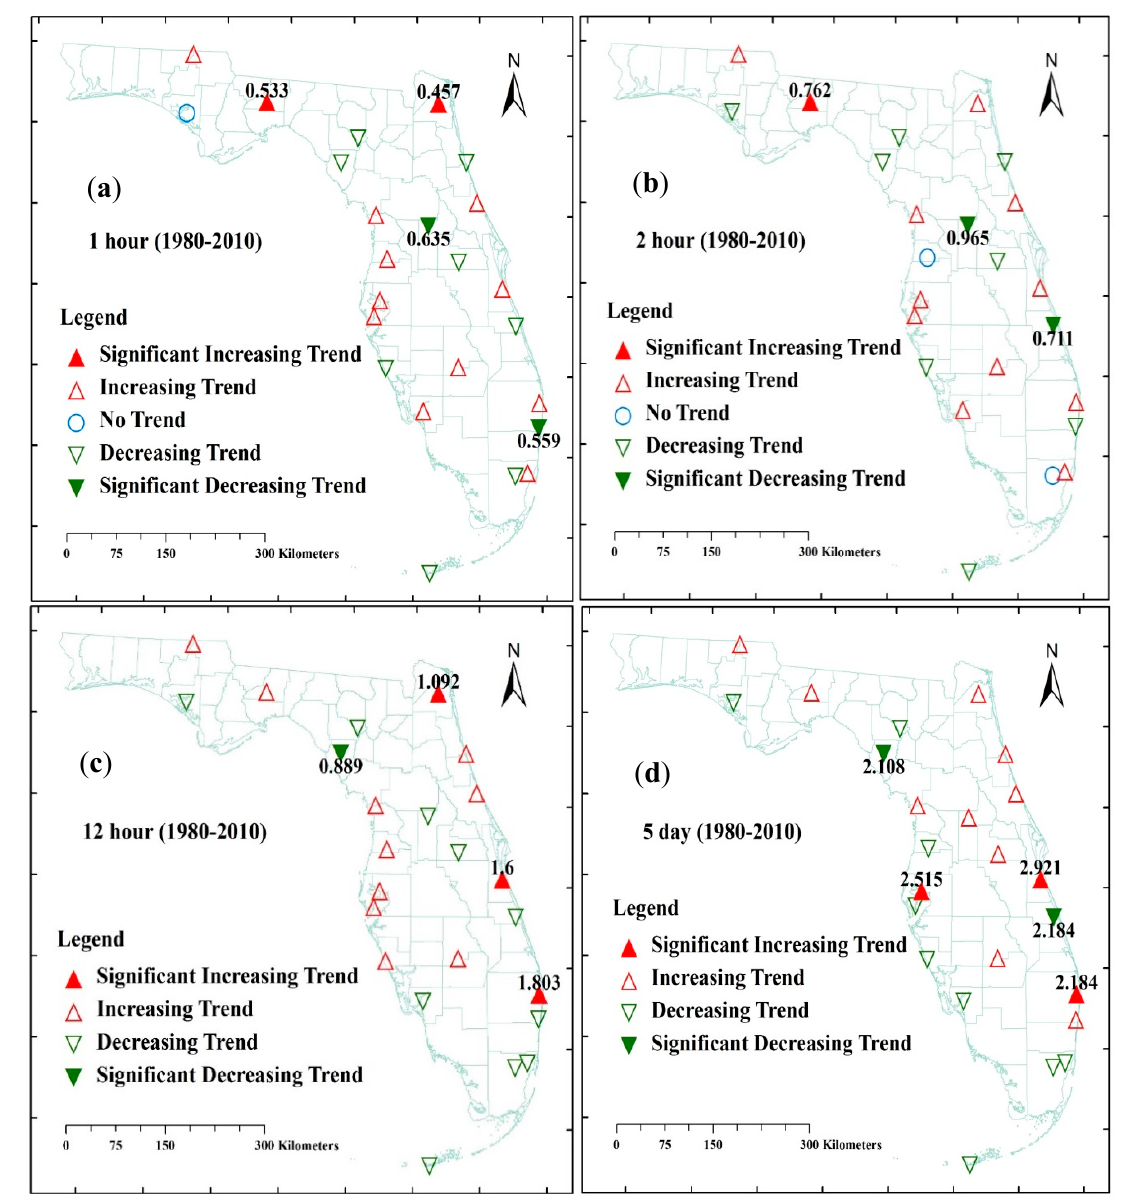
Figure 4. Spatial pattern of the trend results for the annual maximum rainfalls of ( a ) 1 h, ( b ) 2 h, ( c ) 12 h, and ( d ) 5 day durations for the 1980–2010 analysis period. The slope value (mm/year) for locally significant trend is also indicated.